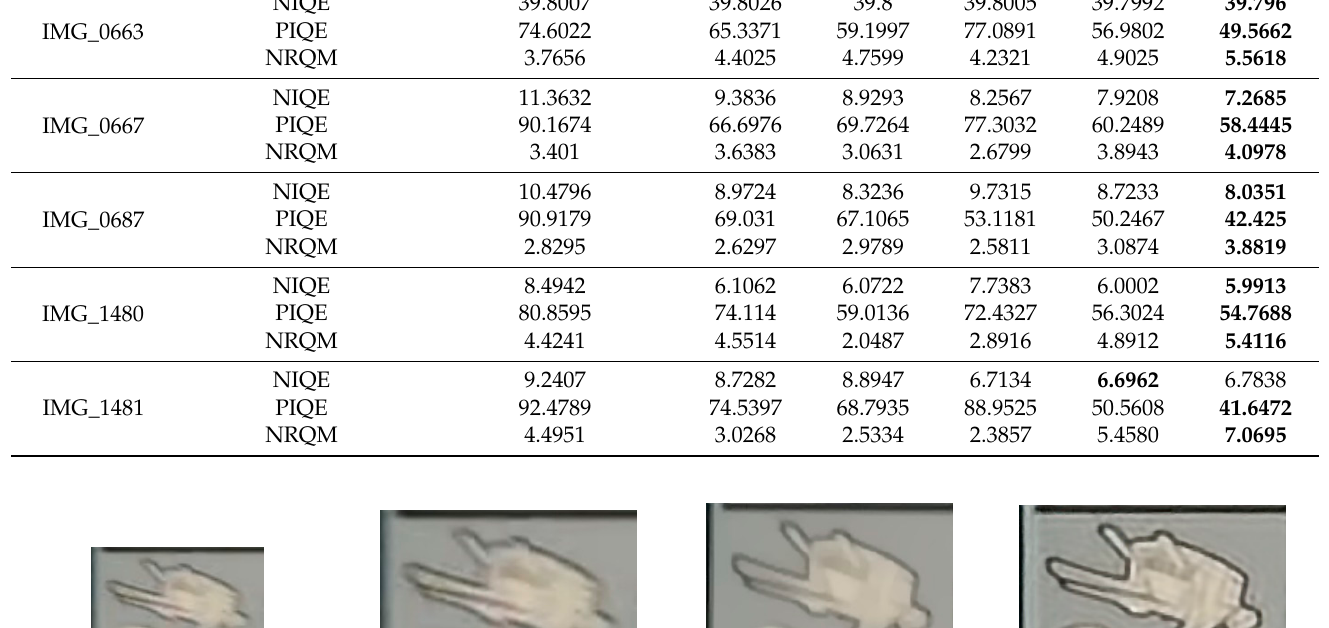
Table 2. NIQE, PIQE and NRQM results of our algorithms on real data when the magnification factor is 5.